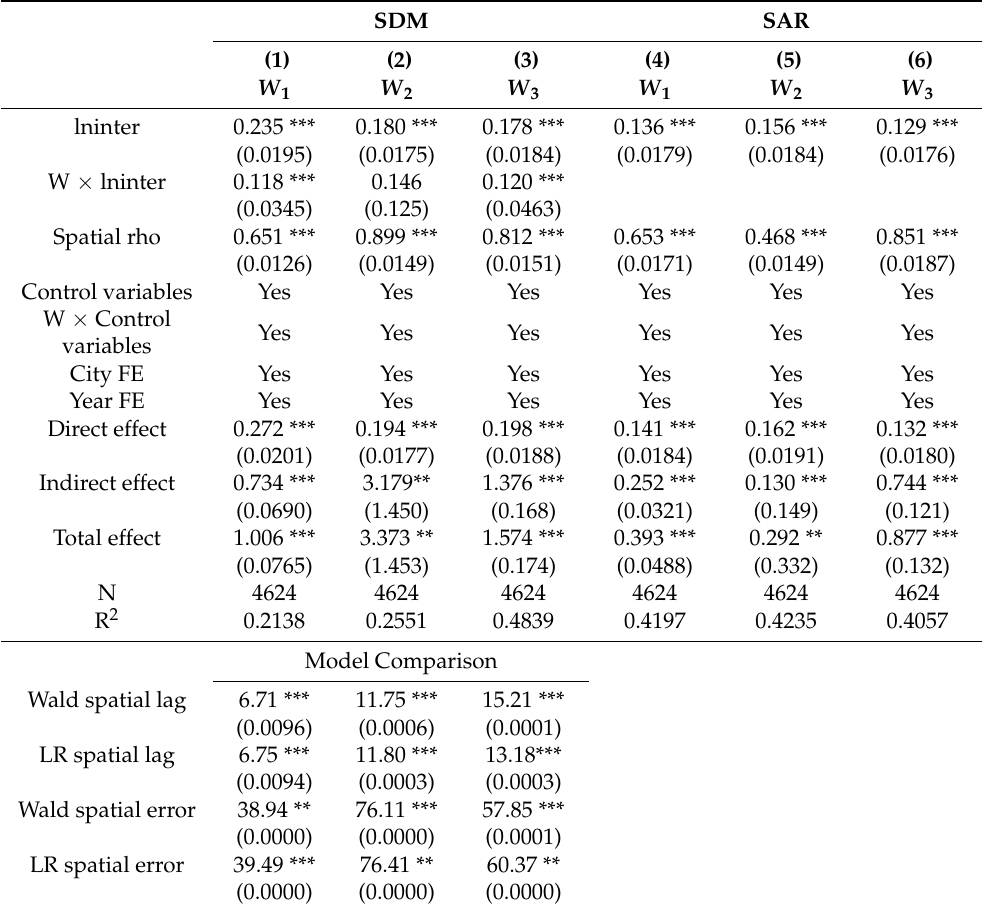
Table 12. Spatial measures of the impact of intermediate goods imports on energy